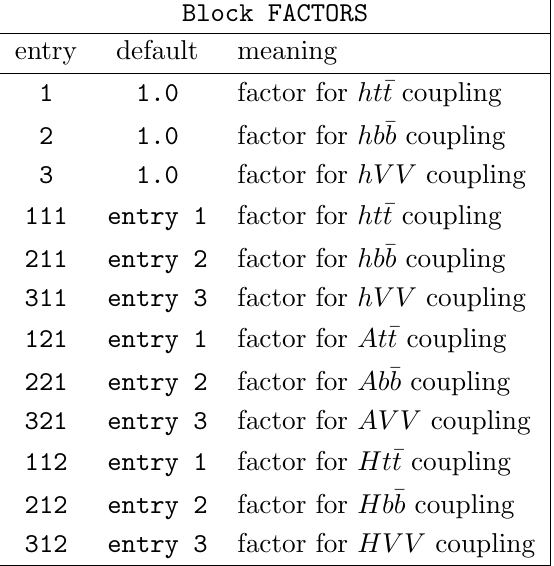
Table 8 . Modifying the Higgs